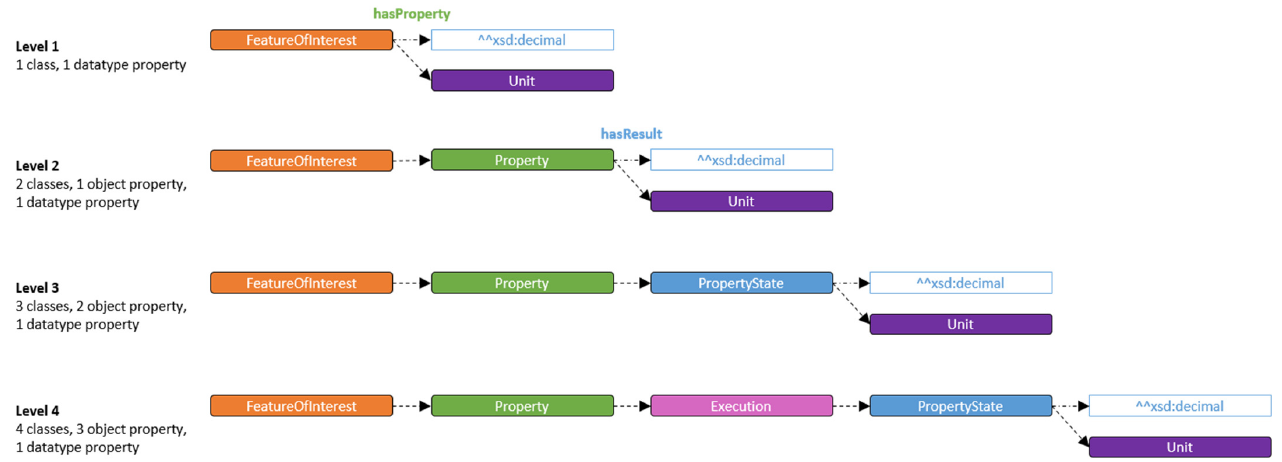
Figure 20. Levels of detail in ontologies describing static and dynamic